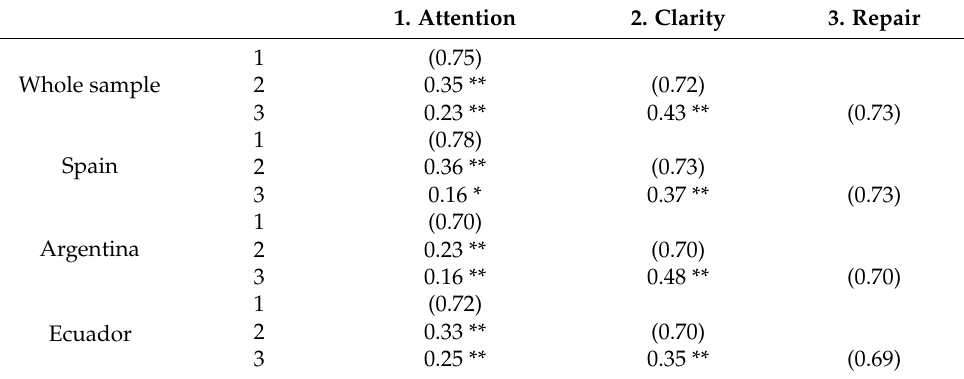
Table 3. Correlations between TMMS-24